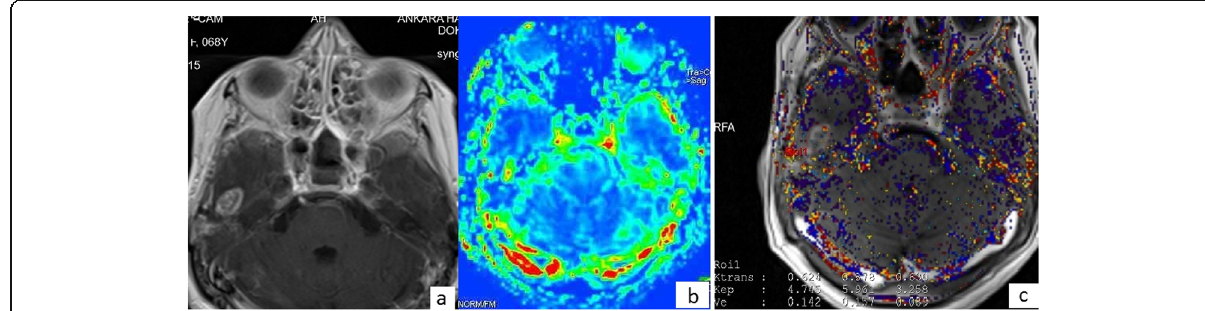
Fig. 3 A 68-year-old female. Enhancing mass in the right temporal lobe is seen on contrast enhanced T1WI ( a , arrow). There is increased perfusion on rCBV map (rCBV 3.20) ( b , arrow). Permeability data indicates high-grade according to Ktrans value (0.678) ( c , arrow). Pathological diagnosis is WHO grade 2